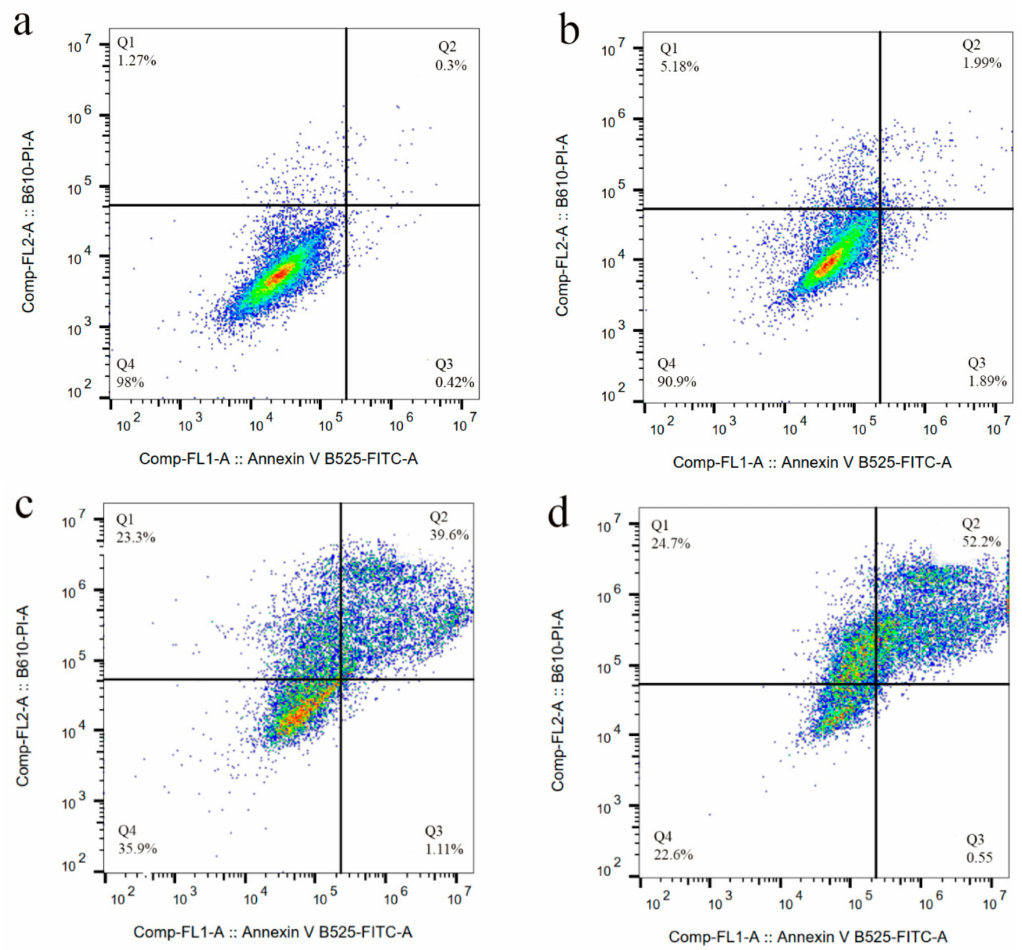
Figure 6. Cell apoptosis / necrosis of U251 upon treatment, stained with FITC-Annexin V and PI: ( a ) control, ( b ) IONPs ( c ) salinomycin, and ( d ) Sali-IONPs, with (Q4) live, (Q3) early apoptotic, (Q2) late apoptotic, and (Q1) necrotic cells.